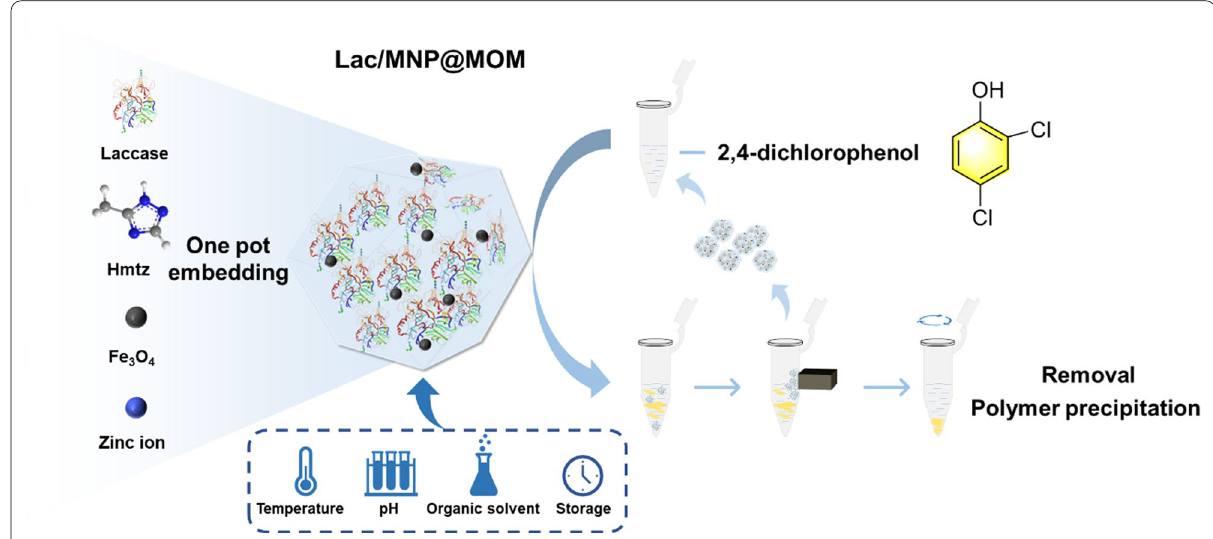
Scheme 1 Schematic diagram for the synthesis of